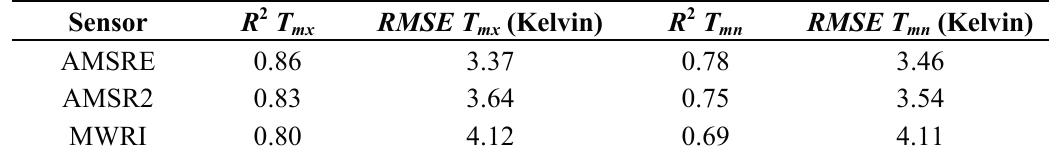
Table 8. Summary of the accuracy of the satellite based daily minimum and maximum air , T ) estimates in relation to independent temperature measurements from temperature ( T mn mx 142 global WMO weather